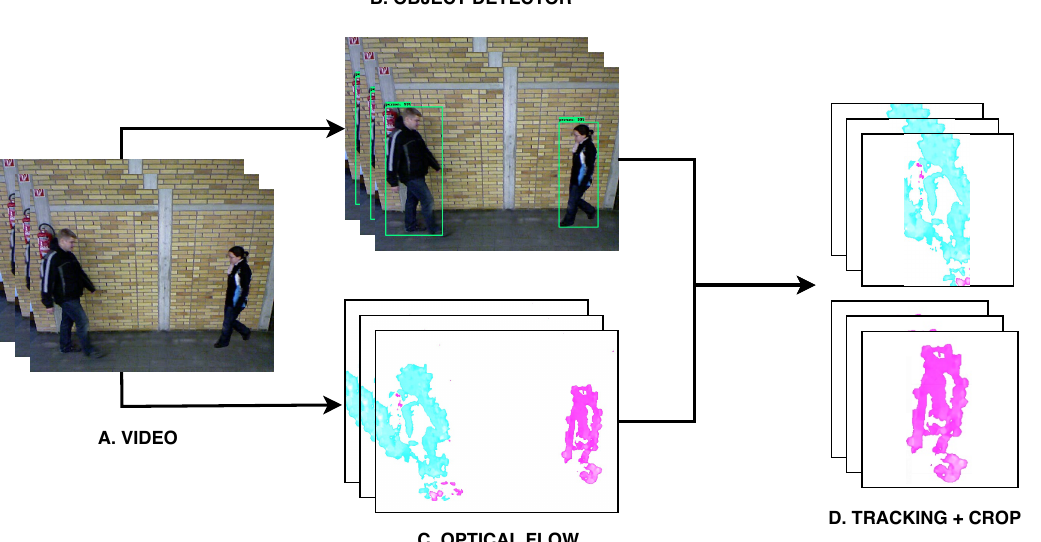
Figure 6. Input data generation. ( A ) The original data are sequences of video frames. ( B ) Persons appearing in the frames are detected and localized using an object detector. ( C ) Optical flow is computed for each pair of frames. ( D ) For each subject, optical flow maps are cropped and combined to produce a common